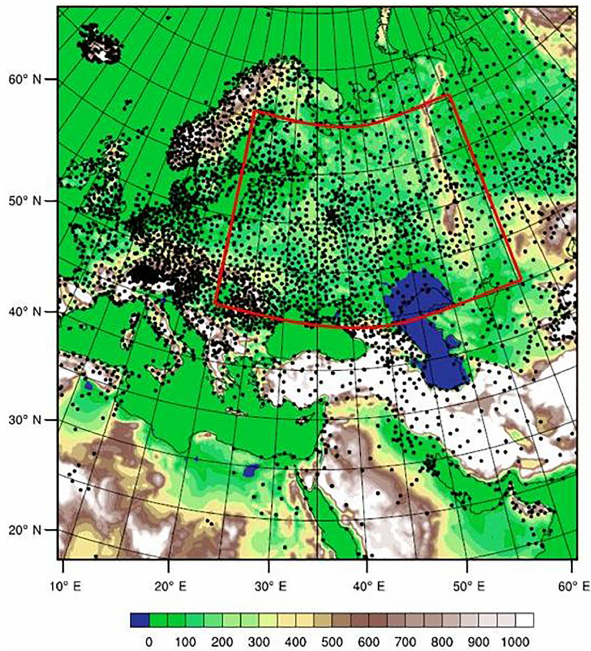
Figure 1. Model domain topographic height. Points are synoptic stations. Red square shows the area used for analyses.